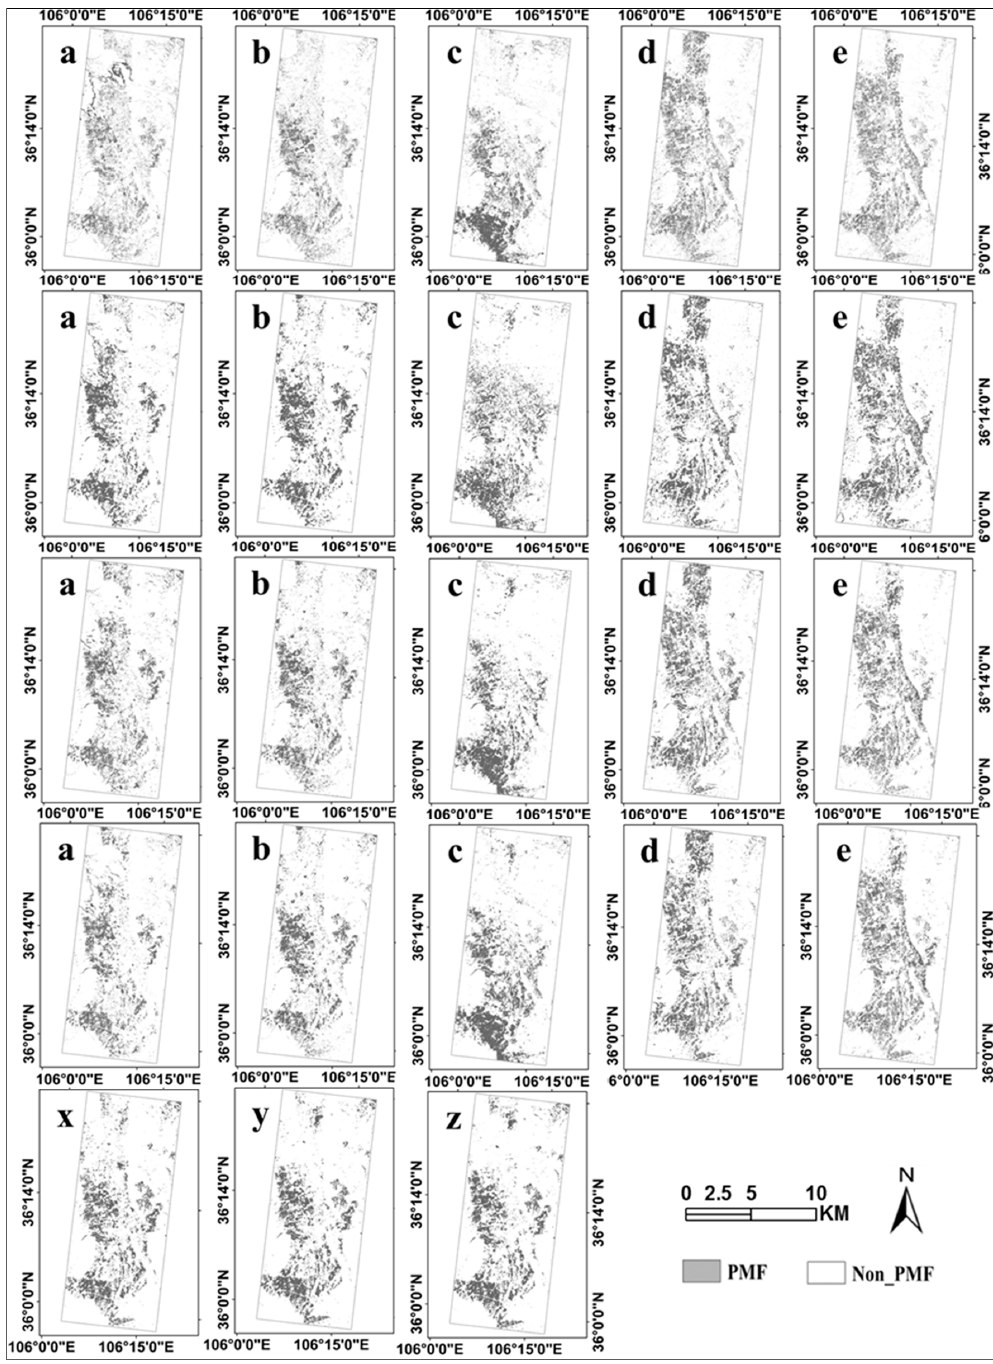
Figure 9. Spatial distribution of PMF in Guyuan using the RF feature selection and RF classifier. The first line represents the results from spectral reflectance features, the second line represents the result from the textural features, the third line represents the results from the total features, the fourth line represents the results from the optimized features, and the fifth line represents the results from optimal temporal combined features. ( a ) 2015.04.26; ( b ) 2015.05.12; ( c ) 2015.06.13; ( d ) 2015.07.15; ( e ) 2015.07.31; ( x ) two-temporal combination of 2015.05.12 and 2015.06.13; ( y ) three-temporal combination of 2015.05.12, 2015.06.13, and 2015.07.15; and ( z ) four-temporal combination of 2015.04.26, 2015.05.12, 2015.06.13, and 2015.07.15.